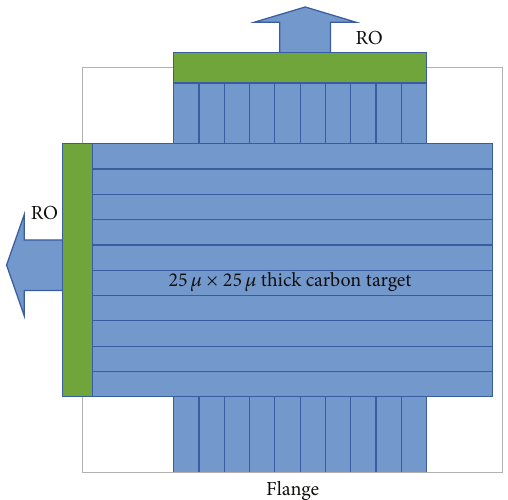
Figure 10: Dependence of the missing mass squared resolution on the vertex position resolution for a 𝑈 boson with 𝑀 𝑈 = 15 MeV.